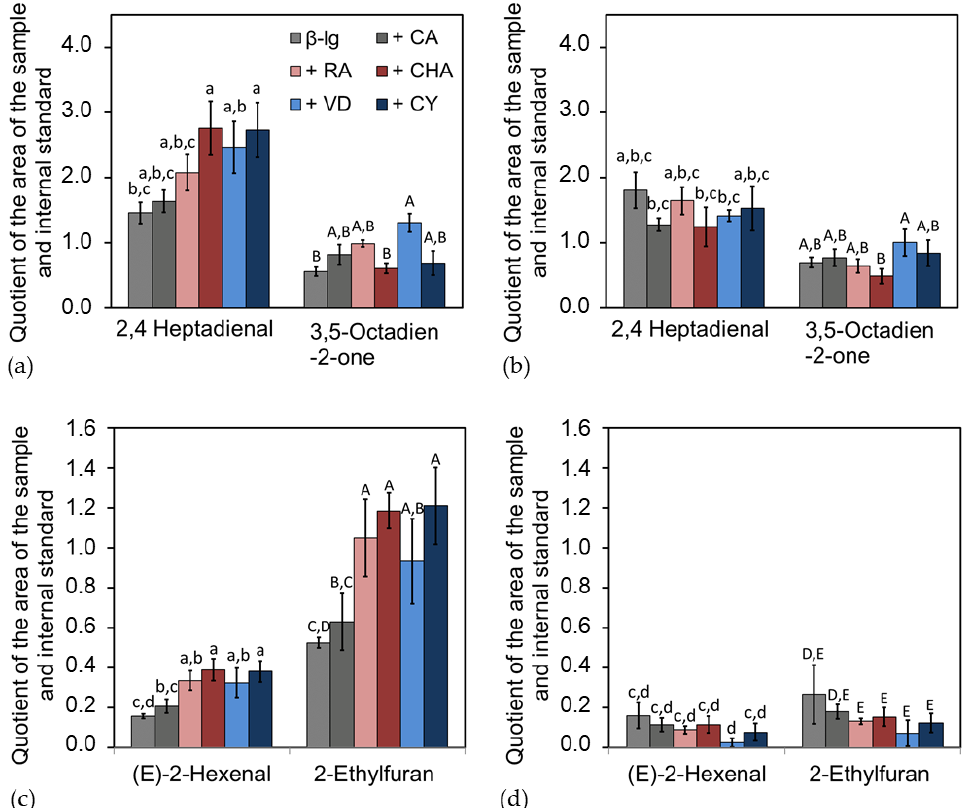
Figure 7. Oxidation products of the linseed oil emulsion after 21 d of storage time, shown as quotient of the internal standard: Quantitative main components of the secondary oxidation products of linolenic acid ( a ) at pH 6 and ( b ) at pH 9; the letters (a–c and A-B) are describing the statistical homogeneous groups without significant differences ( p >0.05) for ( a , b ); and the further reaction of a secondary oxidation product ((E)-2-hexenal) to a tertiary oxidation product (2-ethylfuran) ( c ) at pH 6 and ( d ) at pH 9; the letters (a–d and A-E) are describing the statistical homogeneous groups without significant differences ( p >0.05) for ( c , d ).